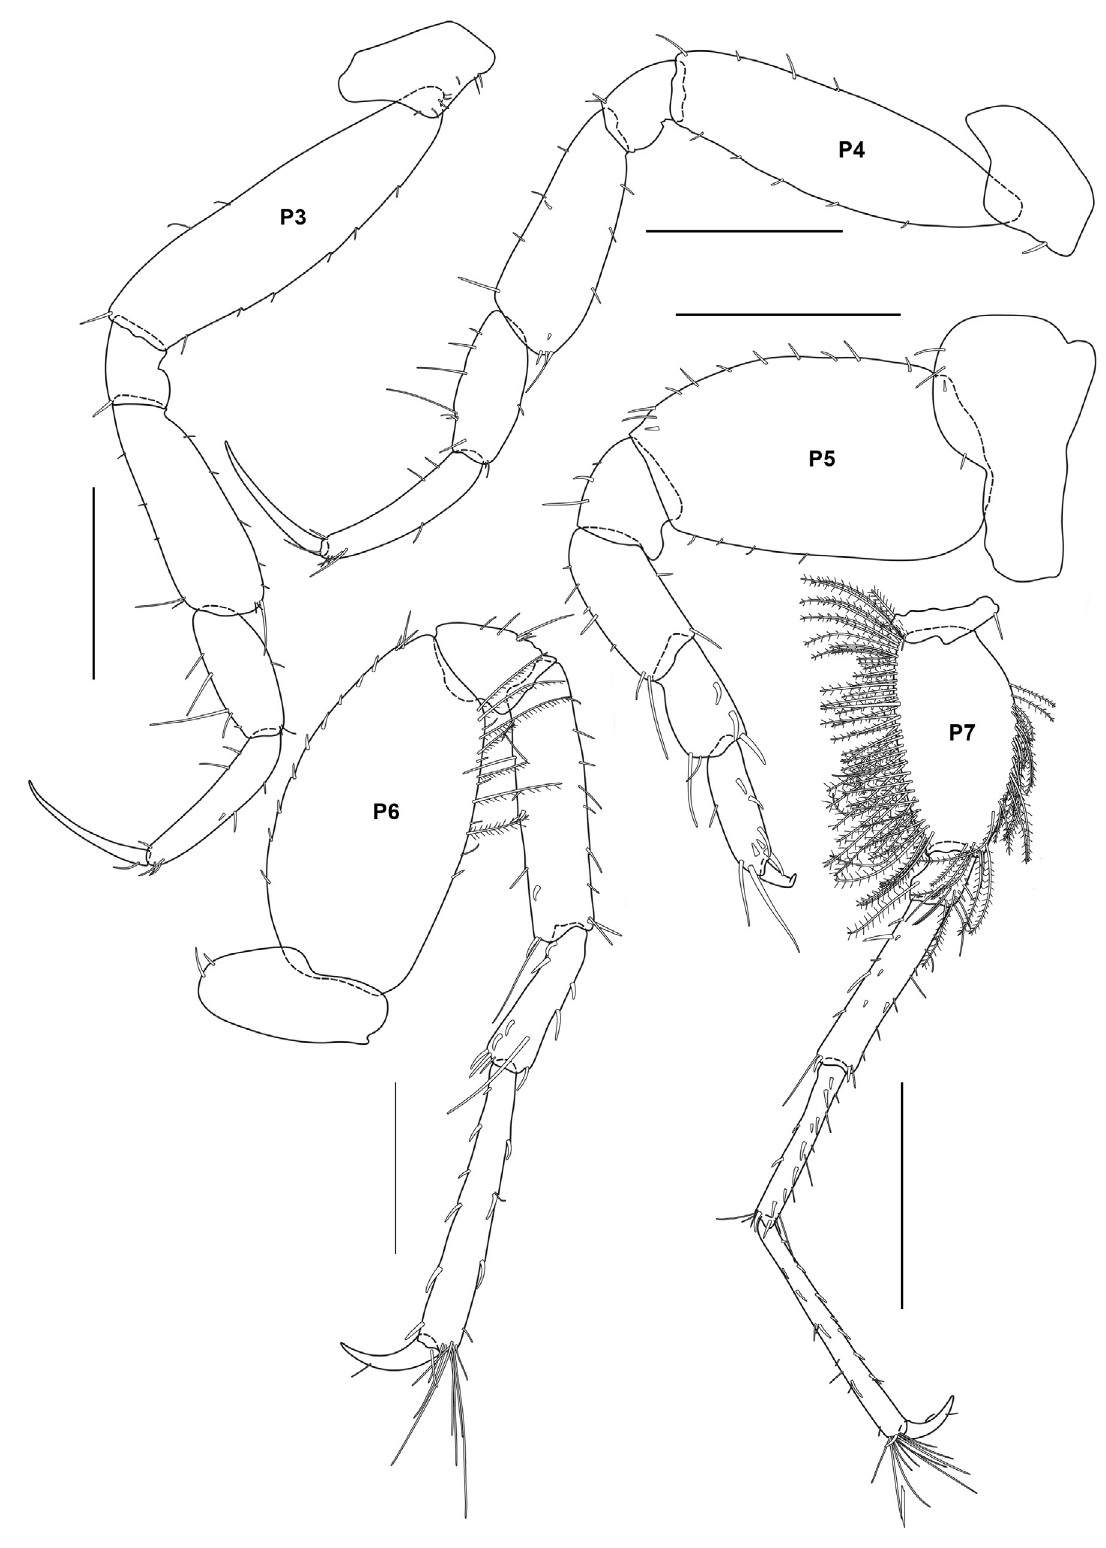
Fig. 14. Grandidierella sungeicina sp. nov., holotype, ♂ (ZRC 2018.0490). Scale bars: P7 = 1 mm; remaining scales = 0.5